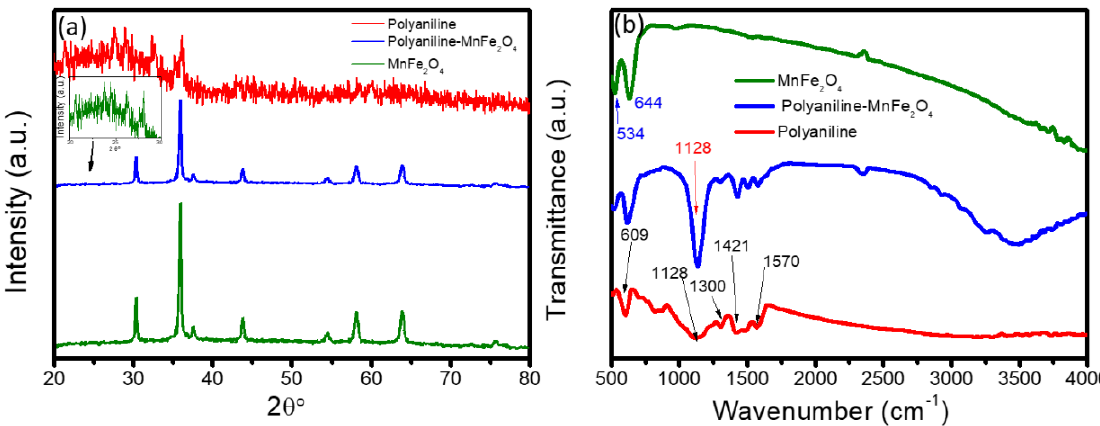
Figure 1. X-ray Diffraction ( a ), and FTIR ( b ) of MnFe 2 O 4 , PANi@MnFe 2 O 4 and PANi.